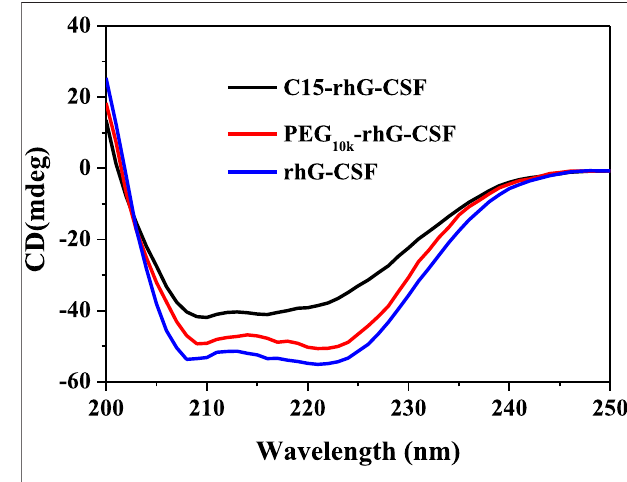
FIGURE 4 | Puri fi cation of C15-rhG-CSF by preparative liquid chromatography. FIGURE 5 | Analysis of rhG-CSF, PEG 10k -rhG-CSF and C15-rhG-CSF by circular dichroism spectroscopy